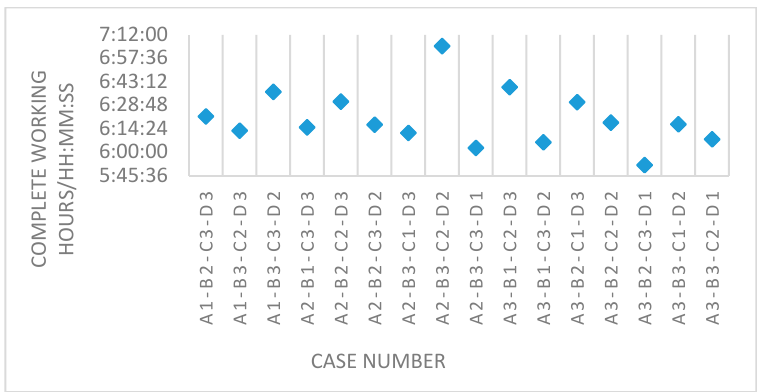
Figure 12. Completion time under 9 AGVs